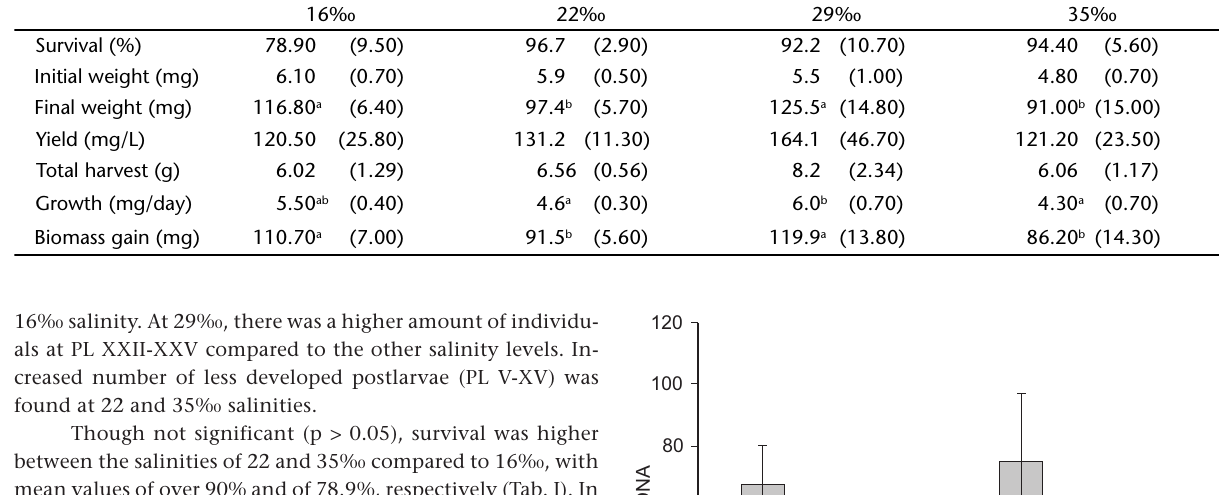
- PL ) acclimated and reared in clear water of four different salinities (16, 22, 18 38